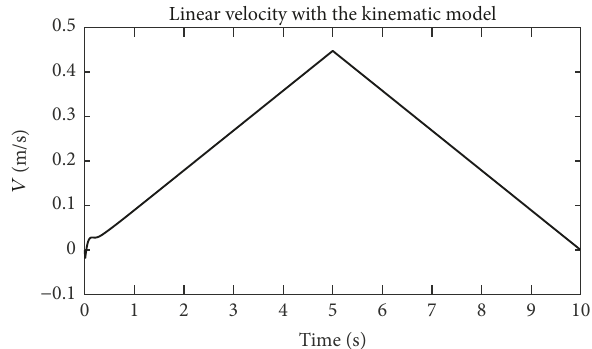
Figure 13: The 𝑦 trajectory tracking using the predictive control joined with the dynamic